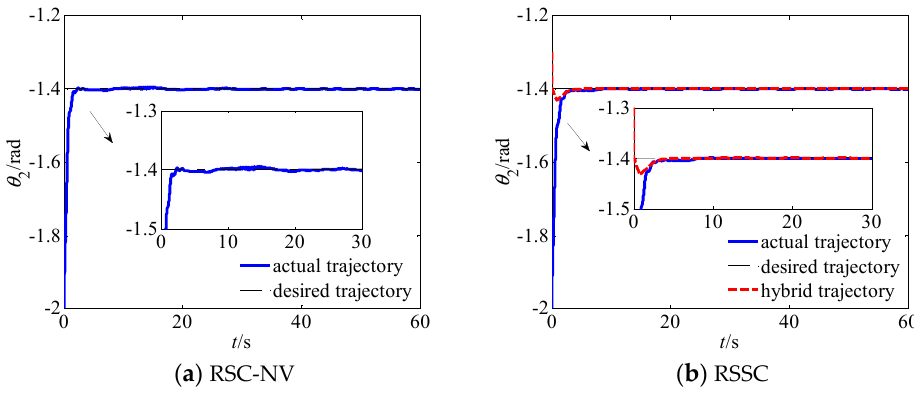
Figure 4. Trajectory tracking curve of the system joint